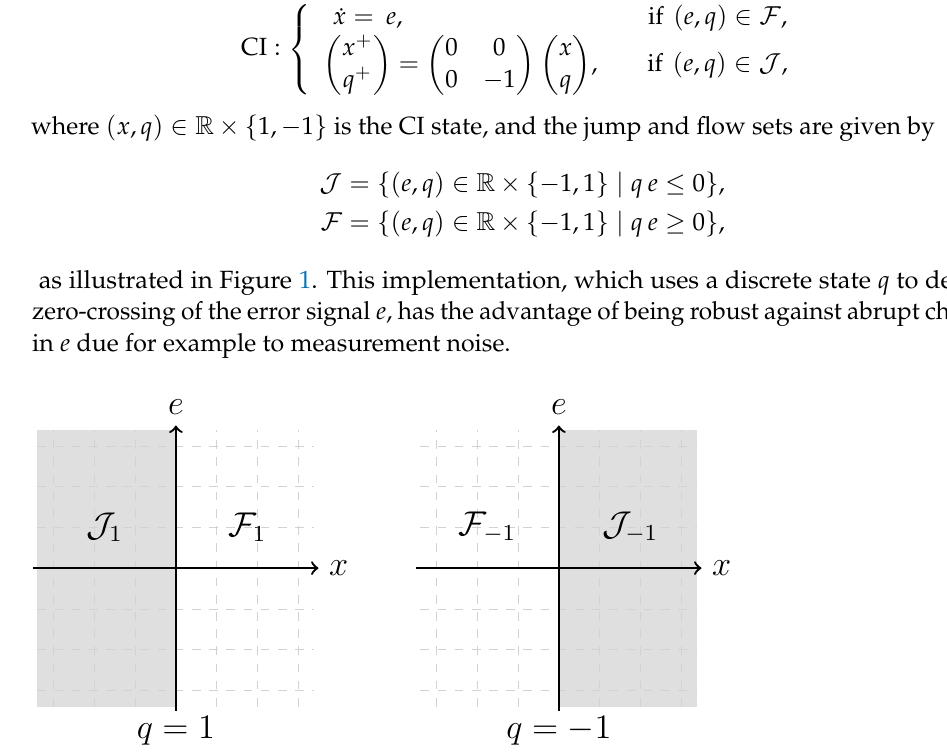
Figure 1. Jump and flow sets for the zero-crossing resetting